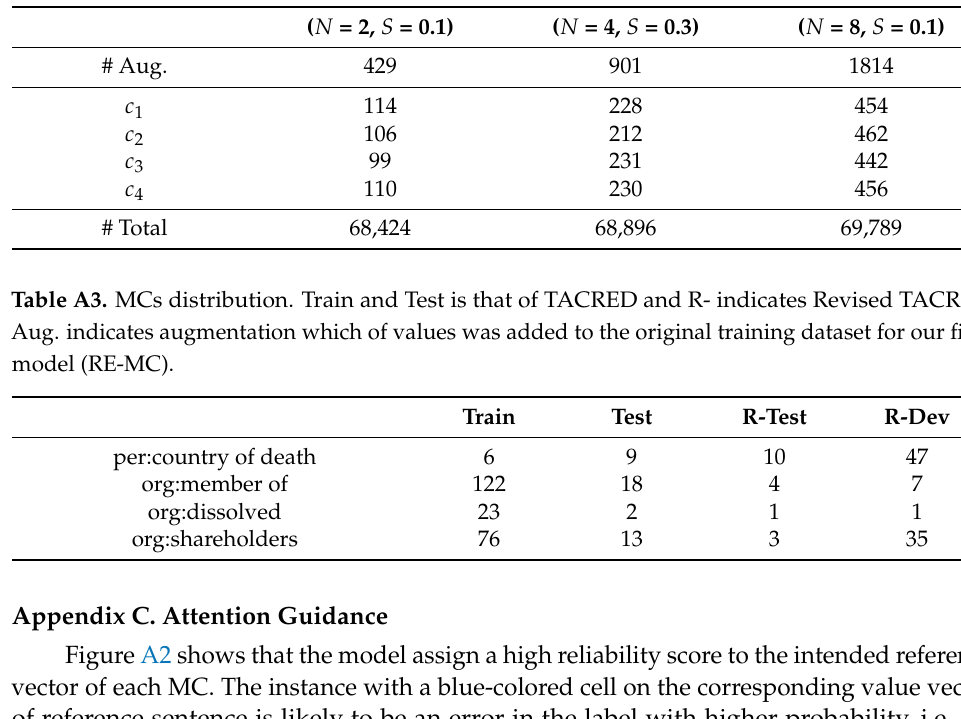
Table A1. Hyper parameters. CE denotes L clf and AG denotes L ref . Name Value Maximum word length 512 Mini batch size 4 Learning rate 5 × 10 − 6 Optimizer AdamW Warmup steps the first 10% of steps of the first epoch Weight decay 1 × 10 − 4 Initial training epochs 5